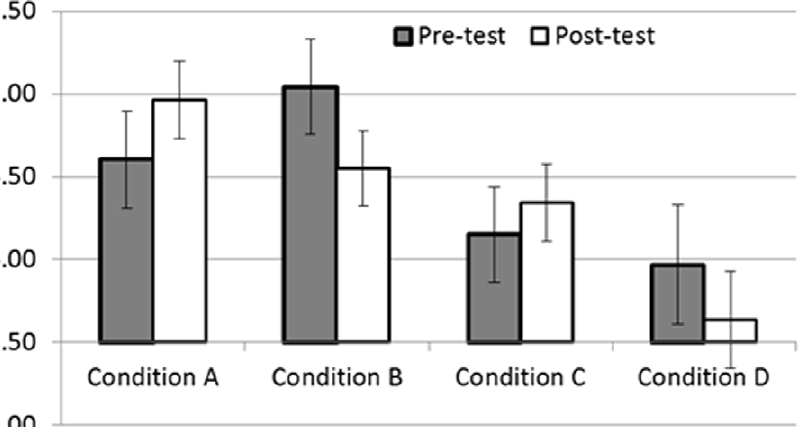
Figure 2. Mean ‘preference for thinness’ at pre- and post-test, for each condition in Study 1. Those in Conditions A and C were shown thin bodies during the manipulation, while those in Condition B and D were shown large bodies. Those in conditions A and B were shown aspirational models and those in conditions C and D were shown non-aspirational models.